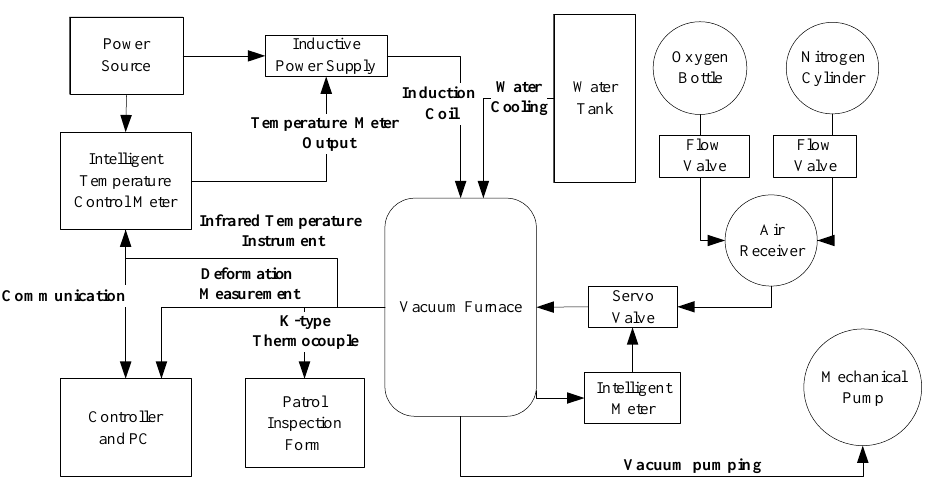
Figure 9. Schematic diagram of the temperature controller.